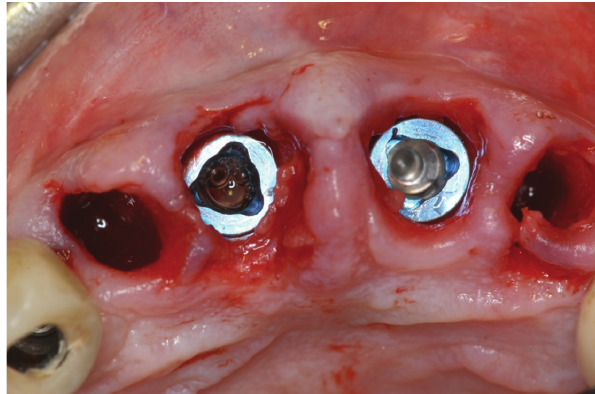
Figure 13: Two postextractive implants are inserted in the incisal area.